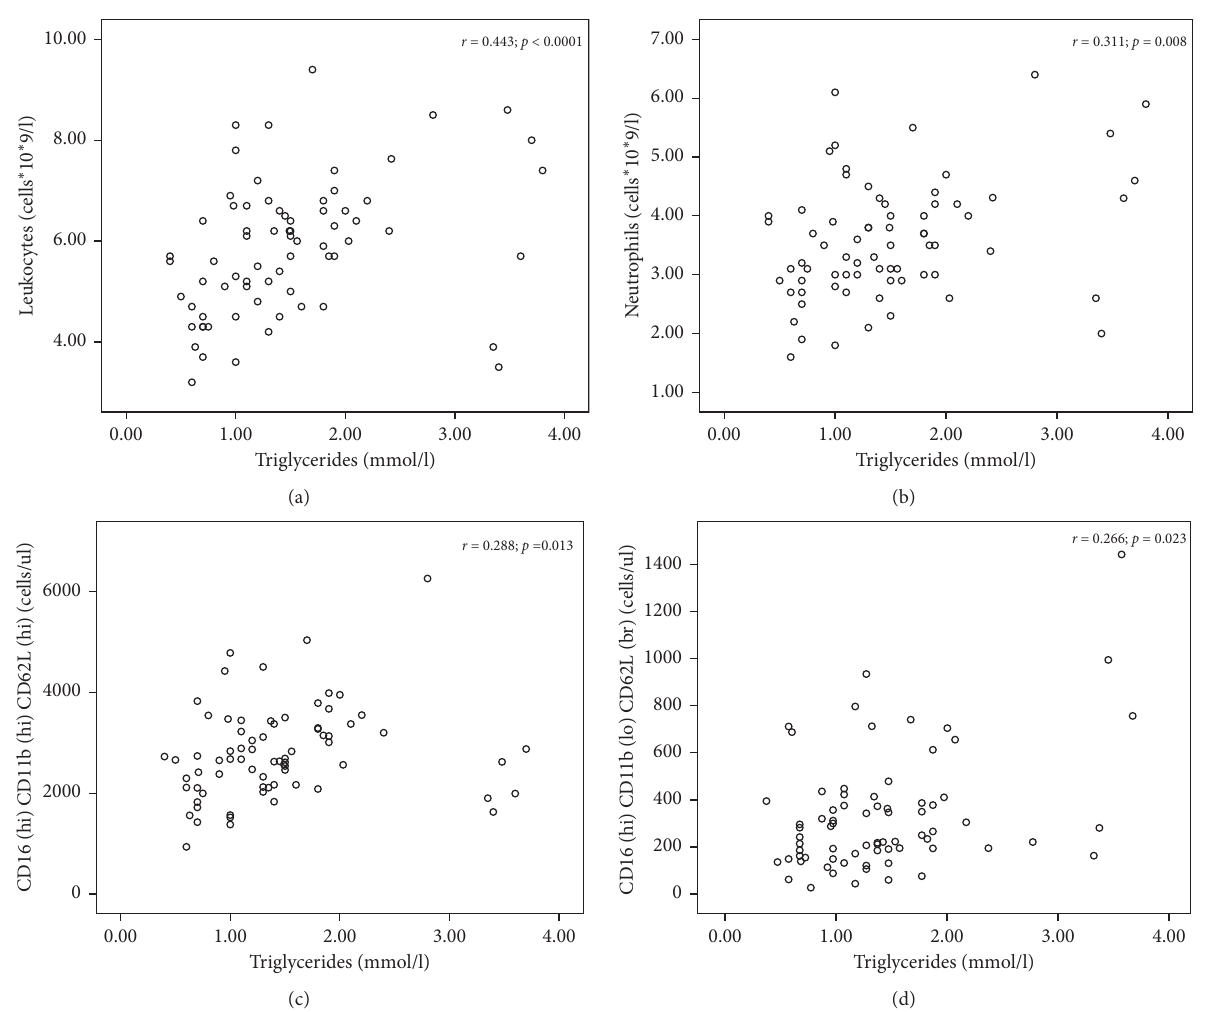
Figure 2: Correlation analysis demonstrating the relationship between TG and leukocytes, neutrophils, and their subpopulations.